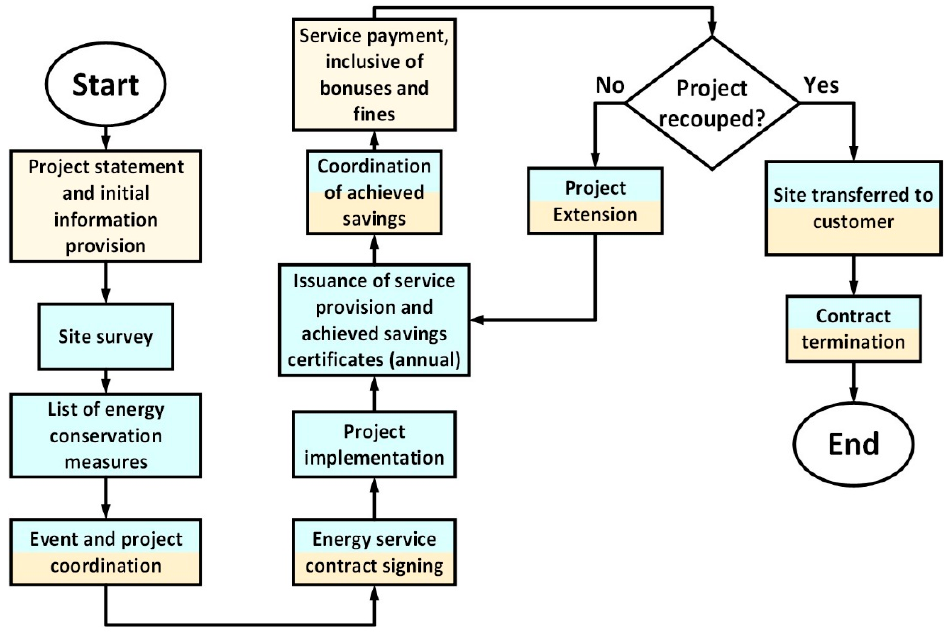
Figure 1. Overview of energy performance contracting.